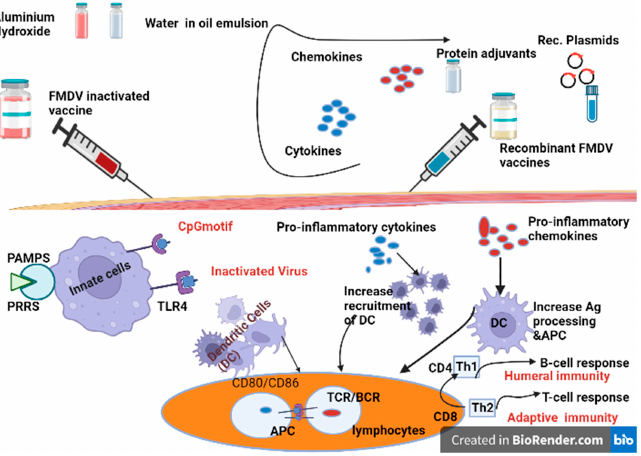
Figure 4. Adjuvants targeting both innate and adaptive immunity and the mechanism action. ( A ) Innate immunity; molecular adjuvants (cytokines, chemokines, and dendritic stimulating mole- cules) incorporated as a gene in the same plasmid and, when co-delivered with the vaccine, can elicit efficient DC recruitment, activation, and Ag presentation to T cells. The CD8+ T lymphocytes are authorized by dendritic cells to become effector CTLs. For this, antigens need to be taken up, processed, and presented by dendritic cells (DCs) in association with MHC molecules. Cytokine adjuvants help sustain CD25+ regulatory T cells (T-regs) of the CD4+ cells. This can significantly improve the immune response. ( B ) Vaccine with adjuvants, such as oil-in-water emulsions and al- munium hydroxide, can stimulate the adaptive arm of the immune system. The maturation of DCs are firstly recognized by CD4+ and CD8+ T cells. CD4+ T lymphocytes undergo a clonal expansion into two distinct T-helper subpopulations following contact with the MHC I-peptide complex. TH1 and TH2 cells stimulate the humoral and cell-mediated immune response through a different cyto- kine expression pattern. TLR4 agonists are considered to be the main ligand to activate DCs. This kind of adjuvant elicits a TH2-type functional immune response with preferential IgG1 antibody production [157–159]. CTL: cytotoxic T lymphocyte; DC: dendritic cell; PAMP: pathogen-associated molecular pattern; PRR: pattern recognition receptor; TLR: toll-like receptor (TLR is a receptor fam- ily belonging to PRRs); Treg: regulatory T cell; Th: T helper cell. Table 6. Common immune adjuvants and their principles for foot-and-mouth disease vaccine. Type of Adjuvant